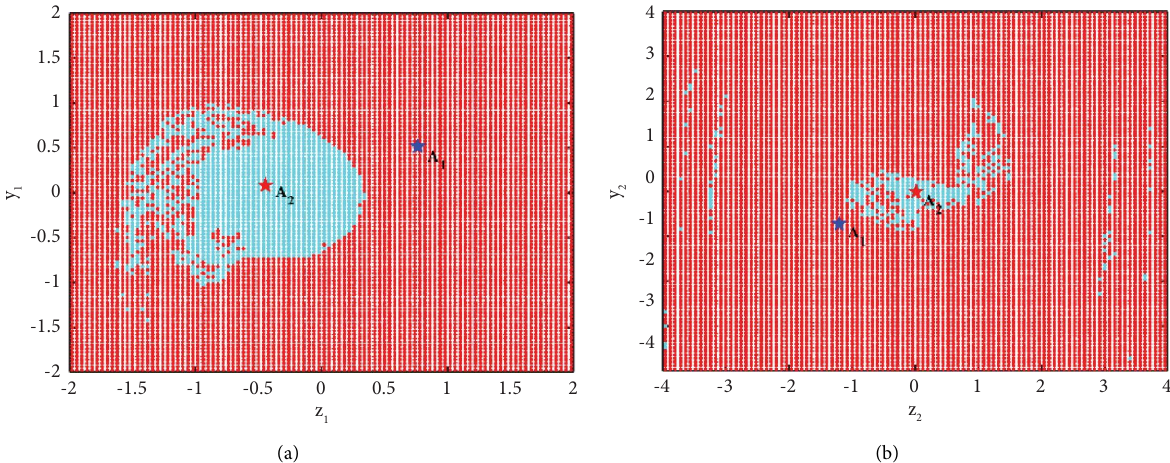
Figure 4: Te attractors and their basins of attraction during system response. (a) Te z